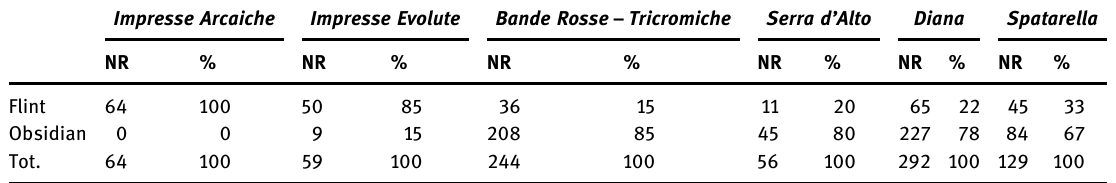
Table 2: Percentage ( % ) of fl int and obsidian artifacts in the di ff erent Neolithic horizons of Grotta San Michele di Saracena Impresse